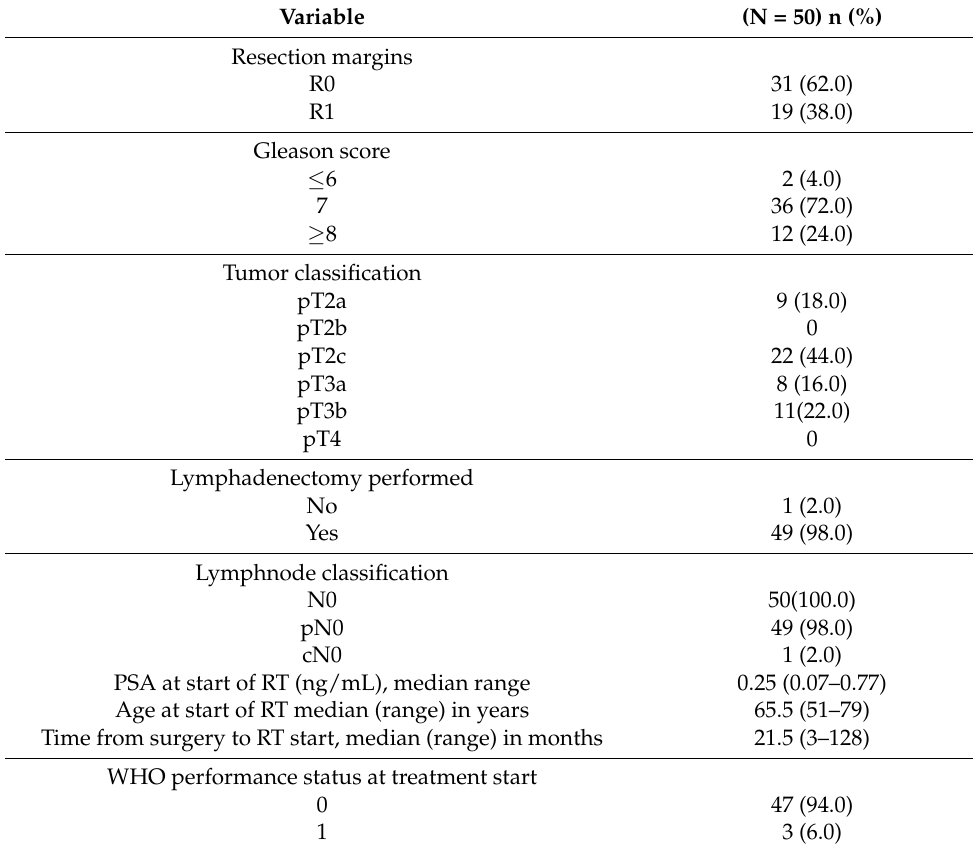
Table 1. Patients characteristics (PSA: prostate-specific antigen; RT: radiation therapy, WHO: world health